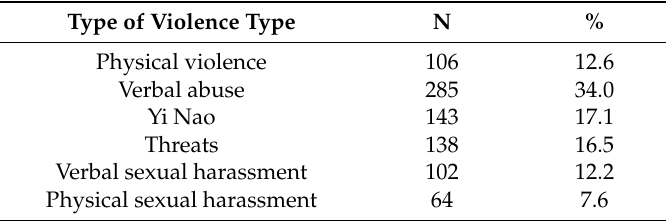
Table 2. Prevalence of workplace violence in the past 12 months ( N =